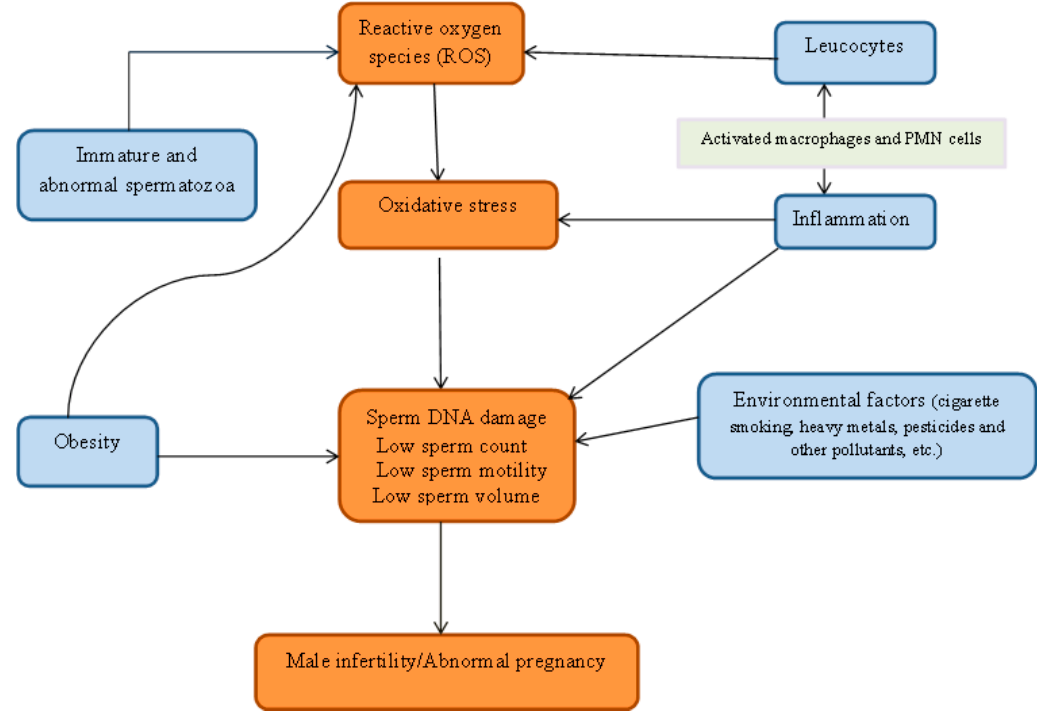
Figure 1. Relationship between reactive oxygen specie, oxidative stress and male infertility.